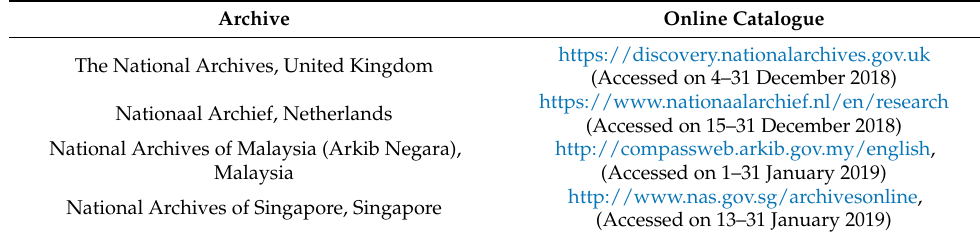
Table 1. Archives explored and their respective online catalogues. N.B. All archives used in our paper make reference to the accession numbers by which the archives can be found back in the catalogues in this